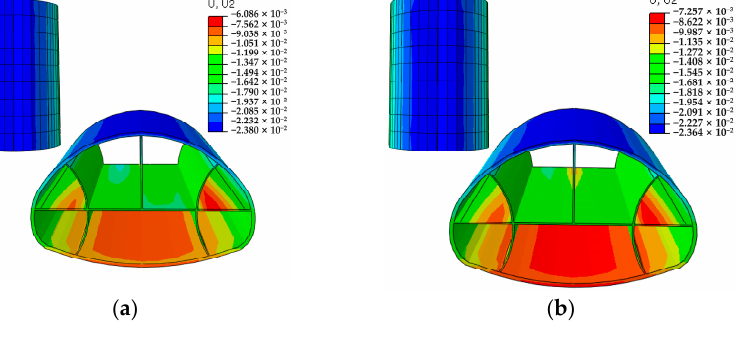
Figure 7. The vertical displacement of the primary support and temporary support in different con- ditions (unit: m): ( a ) Condition 1; ( b ) Condition 2; and ( c ) Condition